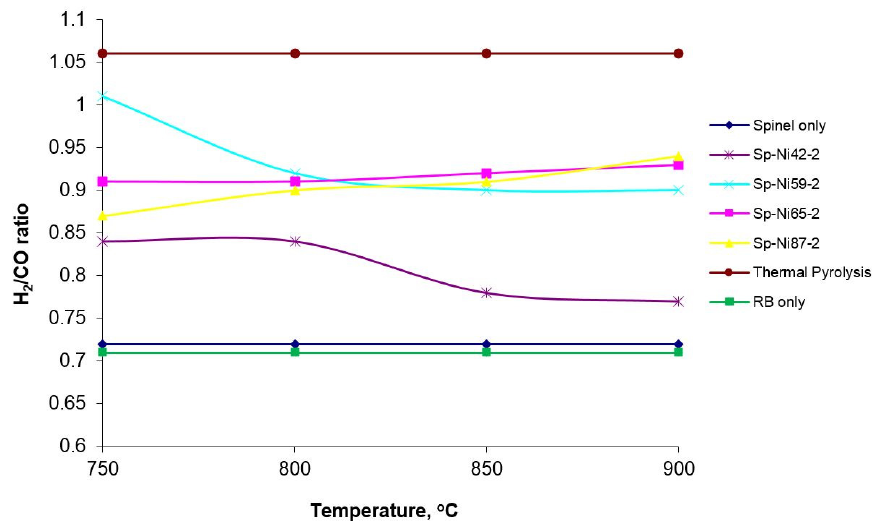
Figure 10. Influence of reaction temperature, type of substrate, and Ni concentration in the initial Ni + Al mixture on the H 2 /CO ratio.